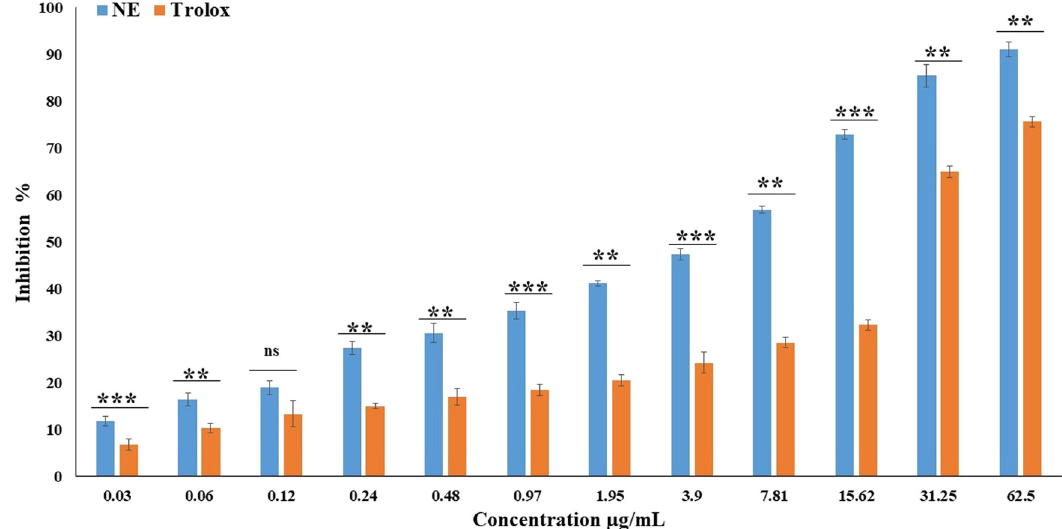
Figure 5: Inhibitory activity of clove bud EO nanoemulsion against ABTS cationic free radicals. Data represents mean ± SD of triplicates. The statistical signi fi cance at di ff erent levels * p < 0.05, ** p < 0.01, and *** p <